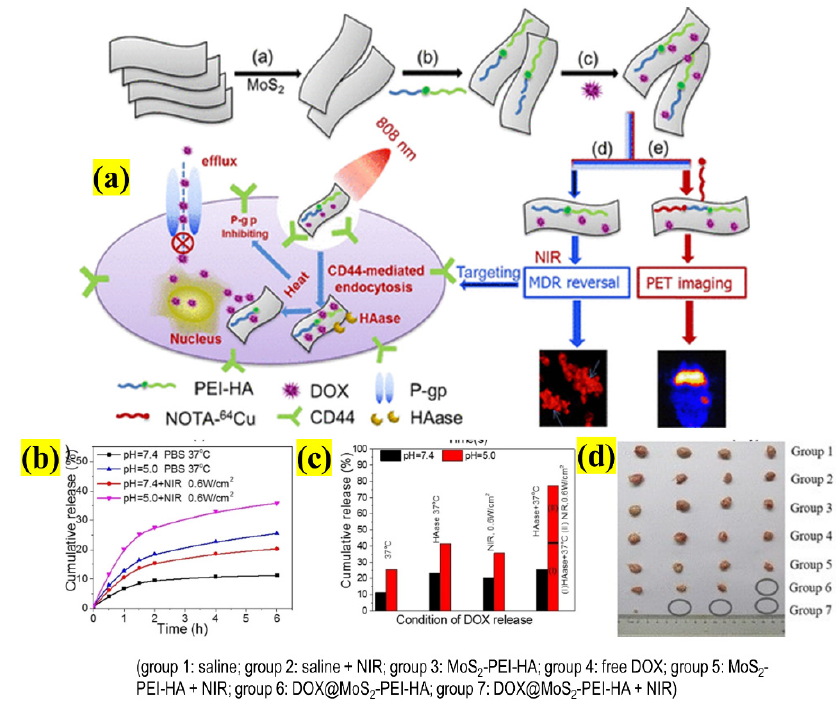
Figure 7. Schematic illustration representing ( a ) multifunctional NSs with surface functionalization of PEI and HA, and DOX to treat ADR by selective targeting and stimuli-based therapy; ( b ) DOX release curve from functionalized NSs with or without laser irradiation; ( c ) statistical data of percent of cumulative DOX release for various values of pH value, enzyme, and NIR laser; ( d ) excised tissue photographs of multiple treatment groups (adapted with permission from Reference [52], ACS Applied Materials & Interfaces, published by American Chemical Society, 2018).